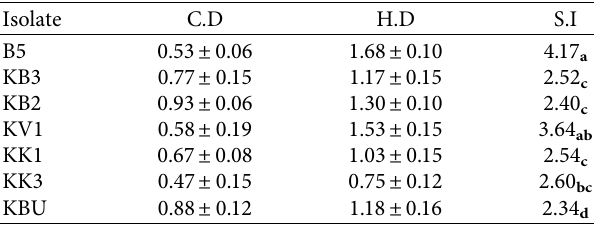
p ≤ 0.05 column C.D is colony diameter (cm), column H.D is halo zone diameter (cm), and column S.I is solubilizing index. Superscript letters indicate statistical signifcance.